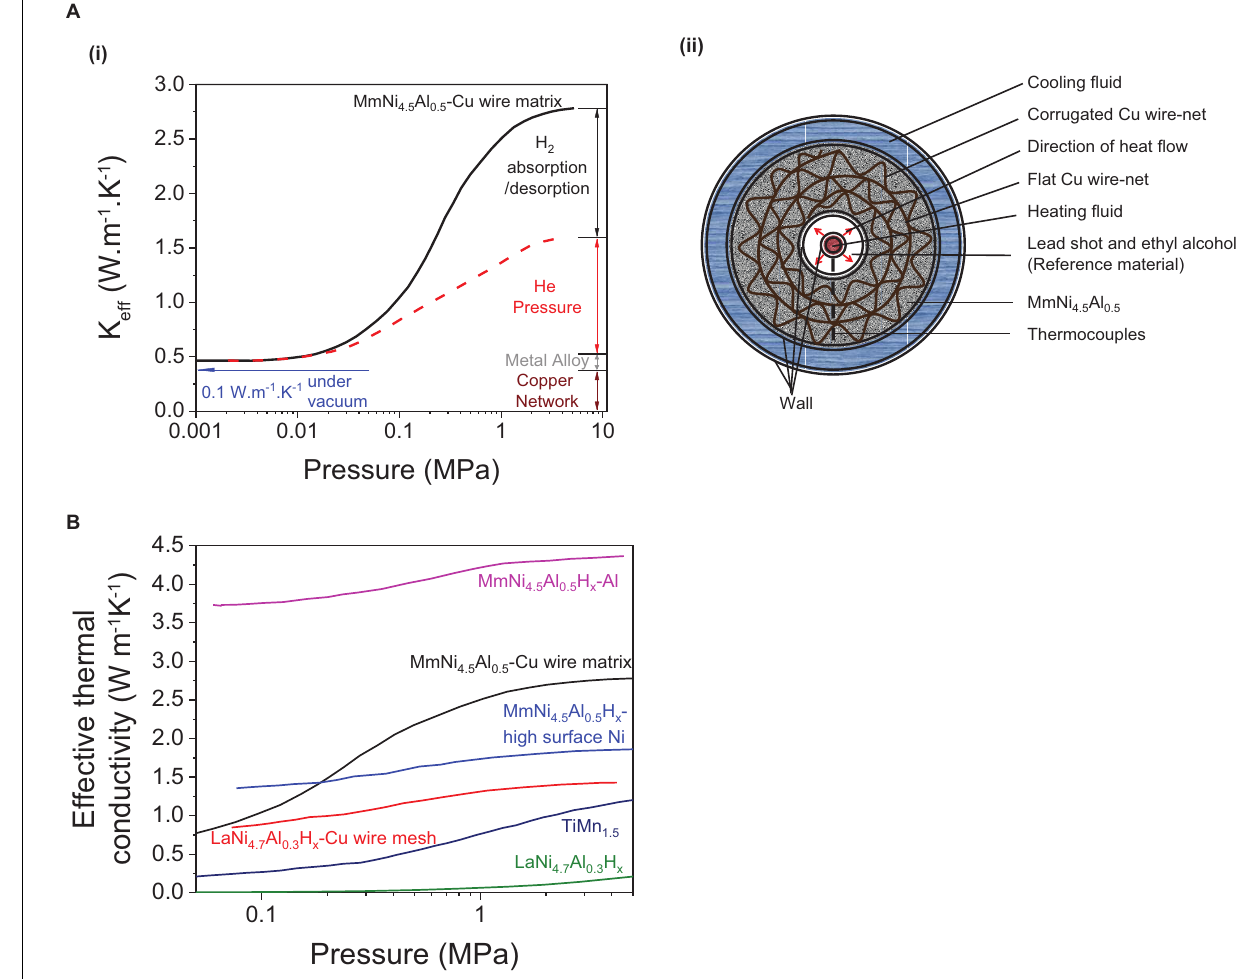
FIGURE 9 | Effective thermal conductivity (K eff ) curve of (A) (i) MmNi 4 . 5 Al 0 . 5 under varying pressures formed due to H 2 , He insertion, metal alloy and copper network and (ii) its related structural model of the tank with the copper wire matrix (Nagel et al., 1986). (B) Effective thermal conductivity curves of various metal hydrides with/without using thermal enhancements (Suda et al., 1980, 1983; Nagel et al.,